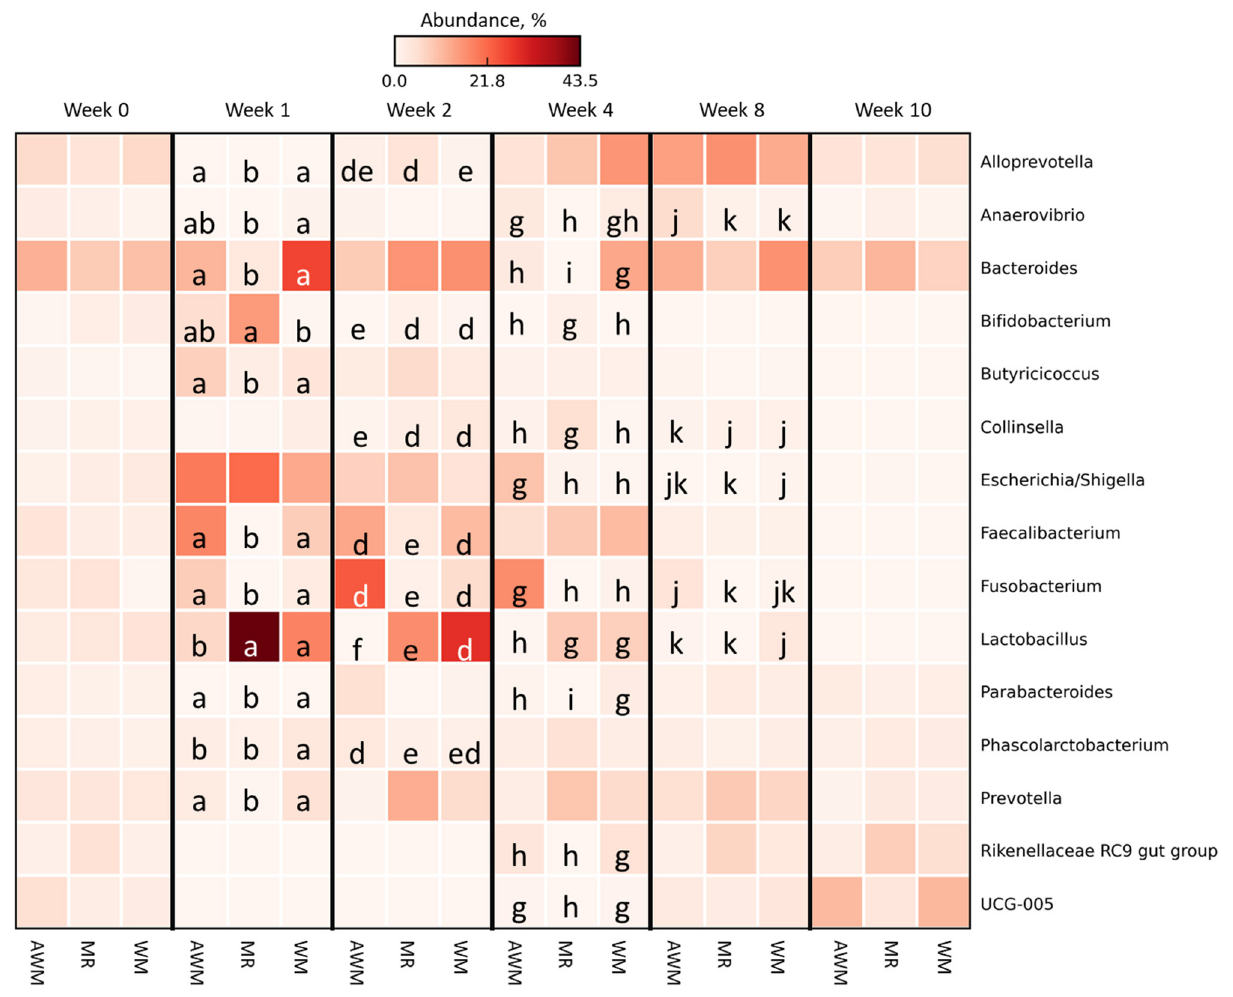
FIGURE 7 | Differential abundance in most abundant bacterial genera in fecal samples of dairy calves fed different liquid diets. Data are visualized as heat-map. Comparisons are among treatments within week. Means followed by the same letter are not significantly different by the t -test ( P > 0.05). Genera rows without letters were not significantly different. AWM, Acidified milk; MR, Milk Replacer; WM, Whole